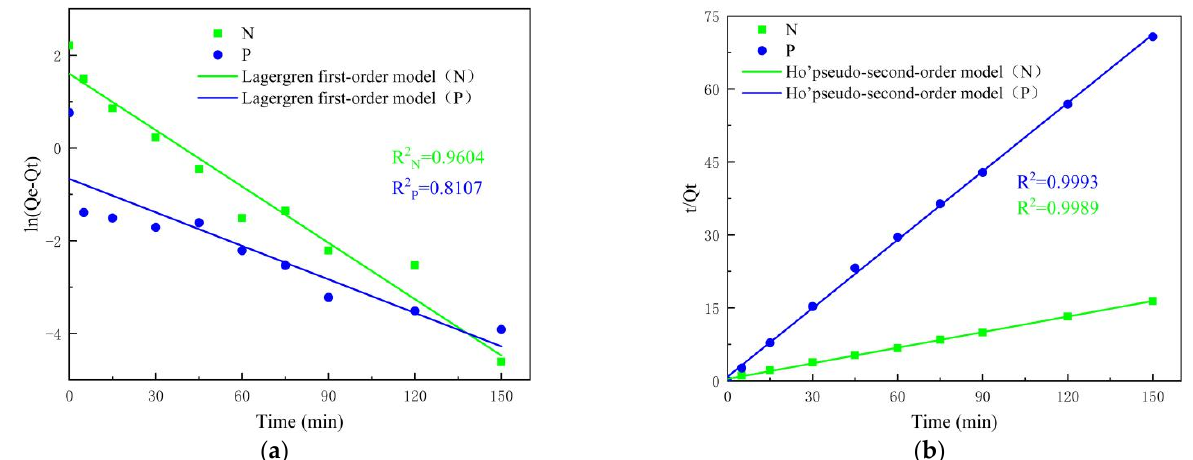
Figure 11. Linearization of ammonium and phosphate adsorption kinetic. ( a ) Lagergren’s first-order model; ( b ) Ho’s pseudo-second-order model. Table 3. Kinetic parameters.